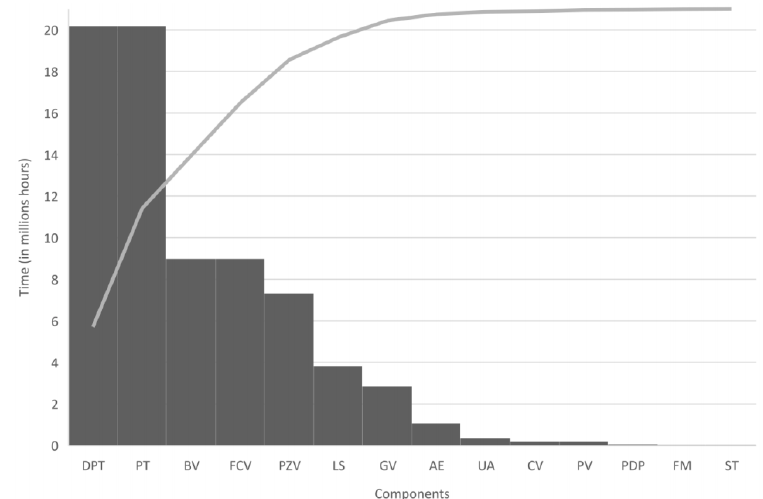
Figure 3. Mean time between failures of unloading system components.